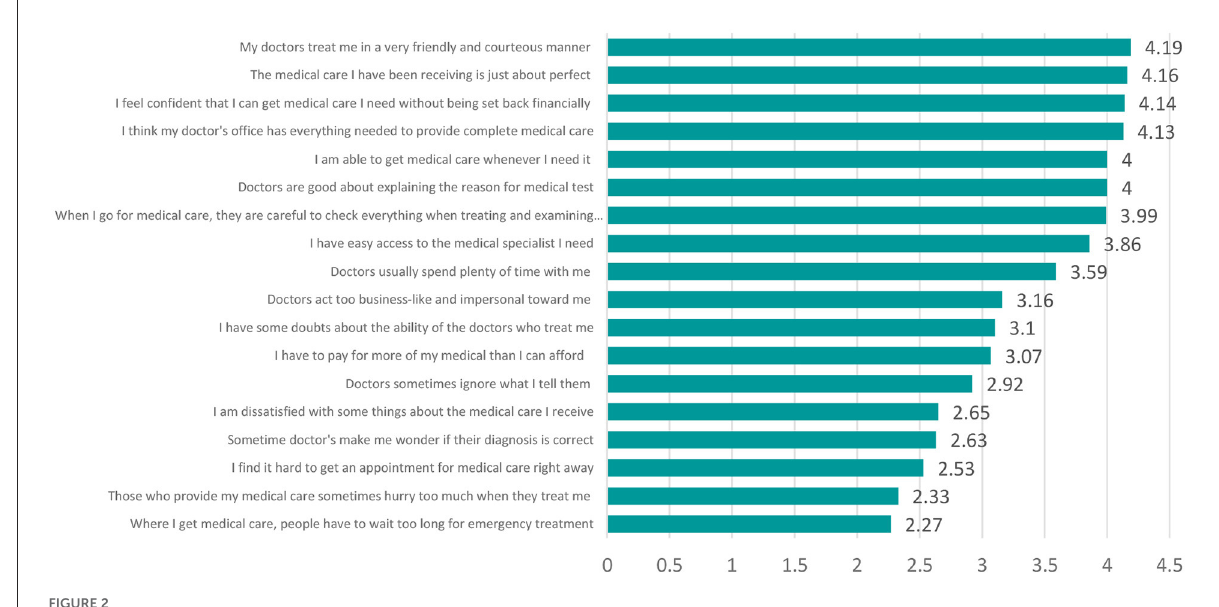
FIGURE2 Comparison of scores given by participants of the study on PSQ-18 items.